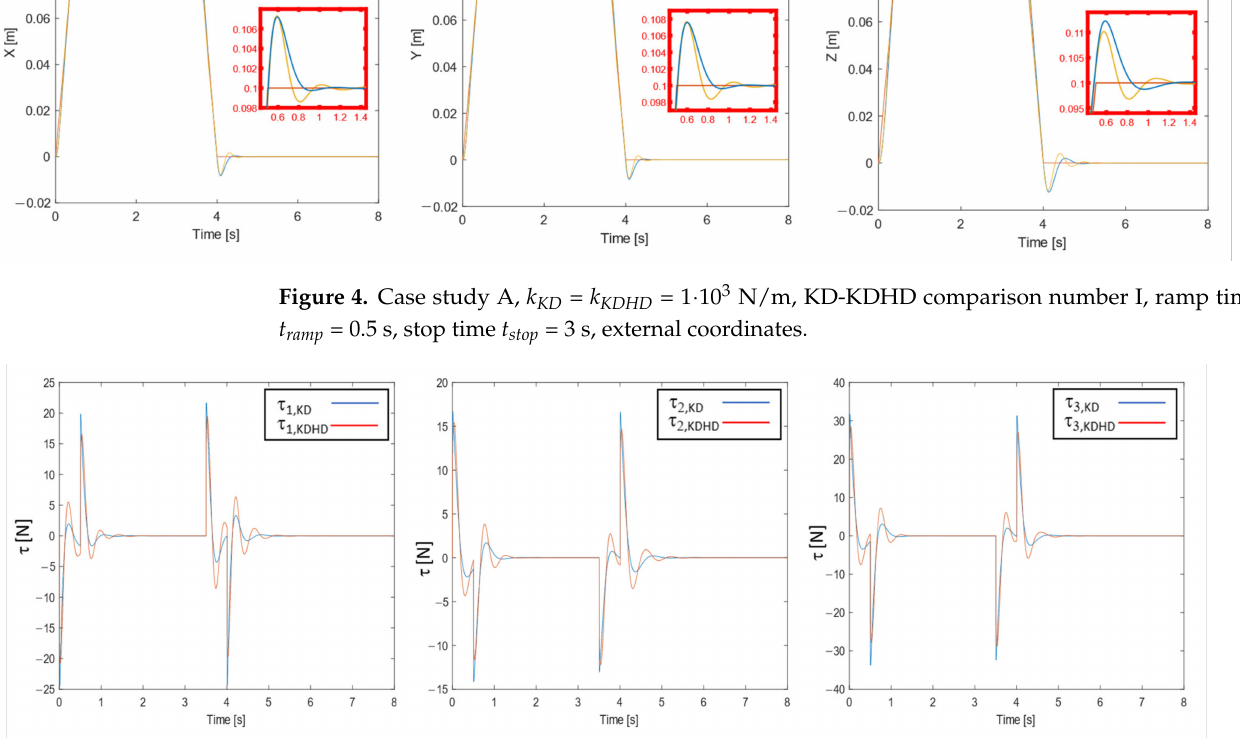
Figure 5. Case study A, k KD = k KDHD = 1 · 10 3 N/m, KD-KDHD comparison number I, ramp time t ramp = 0.5 s, stop time t stop = 3 s, actuation